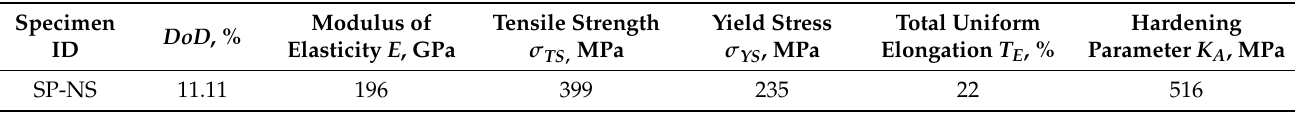
Table 2. Mechanical properties of analysed SP-NS specimens.